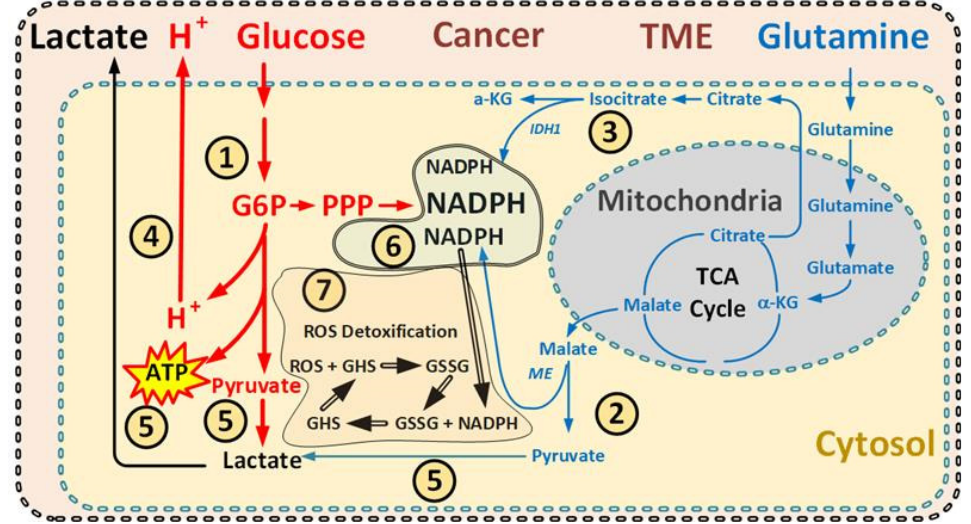
Figure 6. Schematic view over most important NADPH-related pathways in the cytosol and the major pathway for lactate and hydrogen ion production. NADPH plays a vital role in the reduction of the increased oxidative stress in cancer [23,76–78]. NADPH is known to be produced through several fermentable metabolic pathways, where most depend on glucose or glutamine [78,79]. ➀ The most important pathway for NADPH production is the pentose phosphate pathway (PPP) that emanates from glycolysis and depends on glucose for its function [78–80]. ➁ The second most important pathway for NAPDH production is conversion from malate to pyruvate, fueled by glutamine and increasingly important during glucose deprivation [62,79–81]. ➂ In some cancers there is another pathway for NADPH production, mainly glutamine fueled, utilizing isocitrate dehydrogenase [77,79,80]. ➃ Hydrogen ions are produced as a product of the glycolysis pathway (red) and are exported out from the cytosol, thereby contributing to the low pH in the TME [37,69]. ➄ Lactate can be produced either both from glucose (red) or from glutamine (blue) and is exported out from the cytosol (black) and contributes to high lactate levels in TME [37,69]. ➅ Schematically describing the NADPH pool in the cytosol and how it is constantly refilled from pathways mainly dependent on glucose and glutamine [11,79,81]. ➆ The reduction power from NADPH is used to detoxify the cells from oxidative stress. Glutathione (GSH) is one of the most important scavengers of reactive oxygen species (ROS) in cancer cells and when oxidized by ROS to glutathione disulfide (GSSG) it is reduced back to GSG by NADPH [11,74].